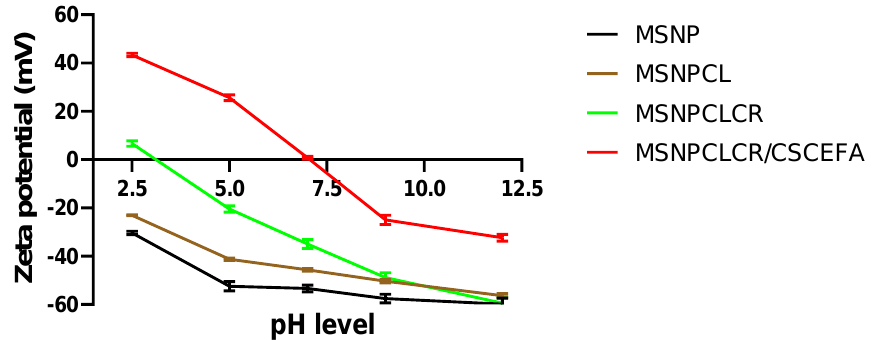
Figure 5. Zeta potential measurement of MSNP and nanoformulations before and after coating, suspended in deionized water. The zeta potential was recorded for the prepared materials at different pH levels presenting the range of low acidic to basic media.